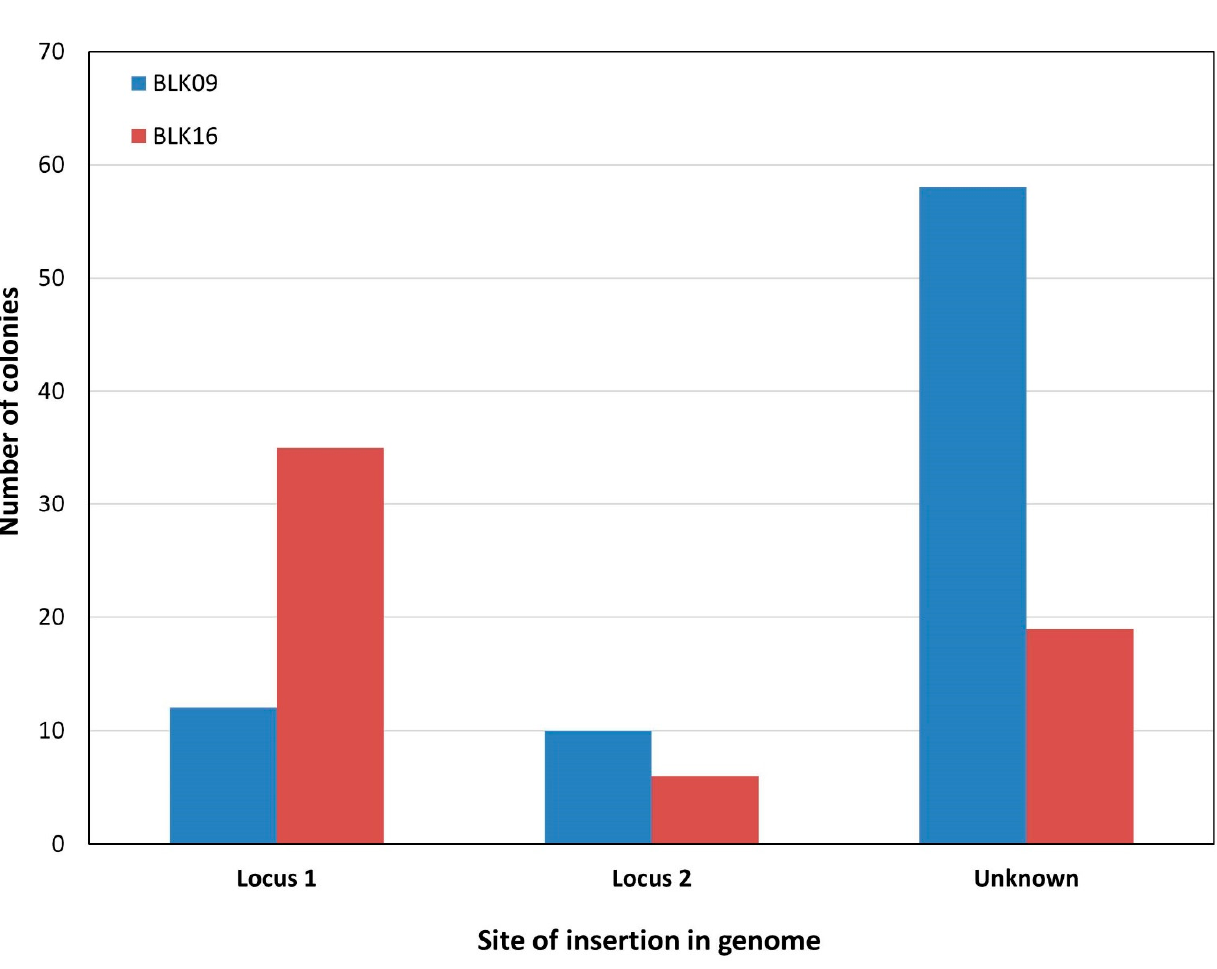
Figure 2. Combined result of recombineering experiments integrating the vioABCDE _Km or vioABCDE _SpR cassette into a chromosomal IS 3 . The number of colonies harboring a PCR-verified integration at locus 1, locus 2, or displaying no PCR-verified integration (“unknown”) are shown for E. coli BLK09 (blue) and E. coli BLK16 (red). The displayed results derive from a set of four similar experiments (two for each